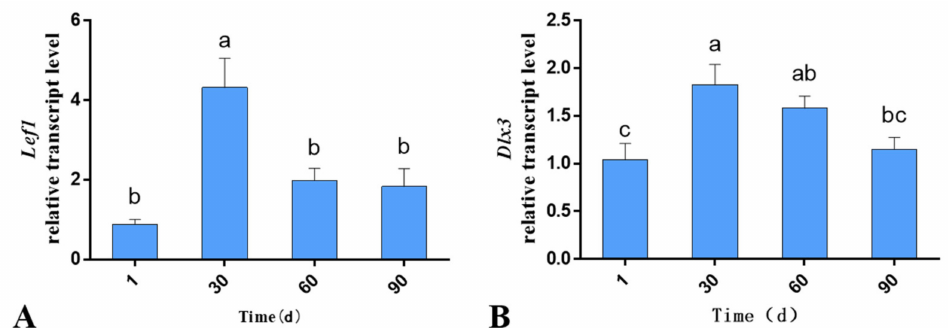
Figure 1. mRNA levels of skin-related genes in Gansu Alpine Merino at various ages. The mRNA levels of Lef1 and Dlx3 were normalized to the level of β -actin mRNA. ( A ) Relative mRNA levels of Lef1 at various ages; ( B ) relative mRNA level of Dlx3 at various ages. The data are expressed as the mean ± S.E. Different letters indicate significant differences between different ages ( p <